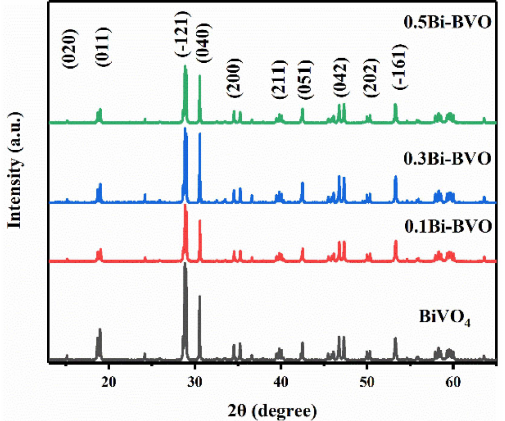
Figure 1. XRD patterns of BiVO 4 and Bi/BiVO 4 samples.